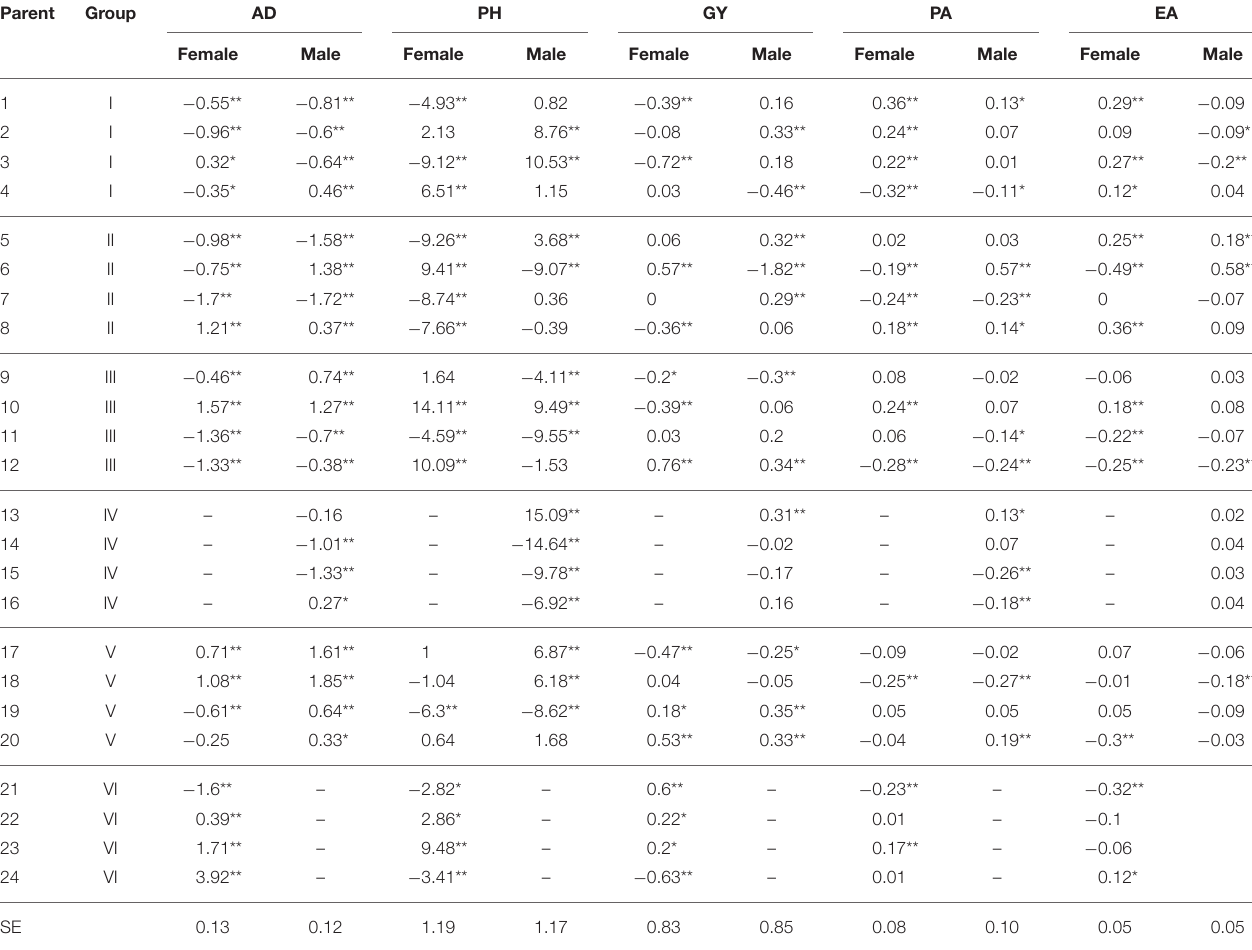
TABLE 5 | Estimates of GCA effects for agronomic traits in 80 F1 maize hybrids produced through factorial mating of 24 inbred lines. Parent